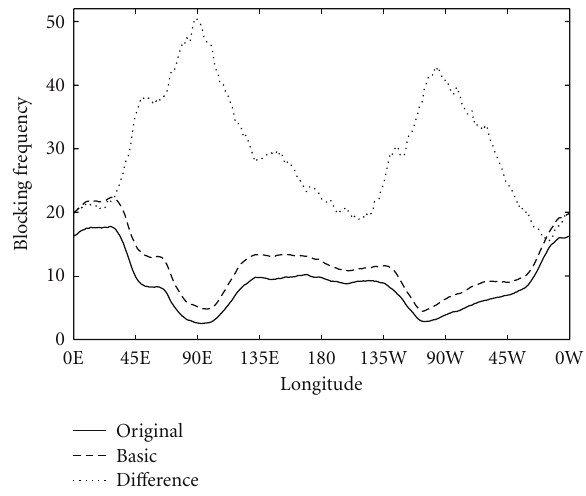
Figure 1: Northern Hemisphere blocking frequency: original TM- Index (solid), TM-Index for varying Δ -ranges in (1) (dashed, basic setup), and relative increase (dotted, in